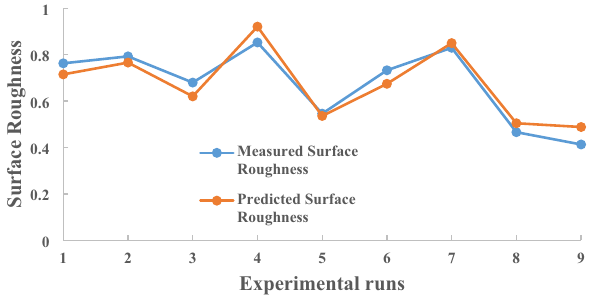
Fig. 5 Measured surface roughness and predicted surface rough-